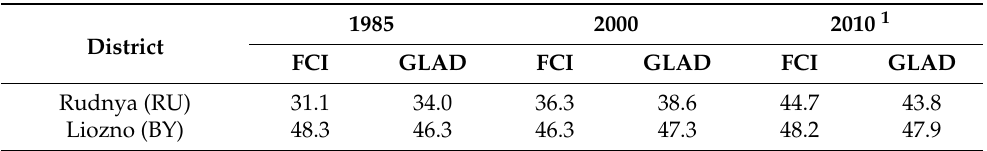
Table 8. Comparison of forest cover values (%) for different years, assessed in our study (FCI) and ones derived from the GLAD group dataset